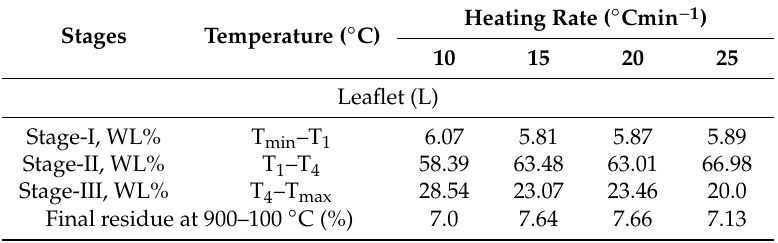
Table 3. Mass loss during the Stages I–III of the DPWP decomposition.